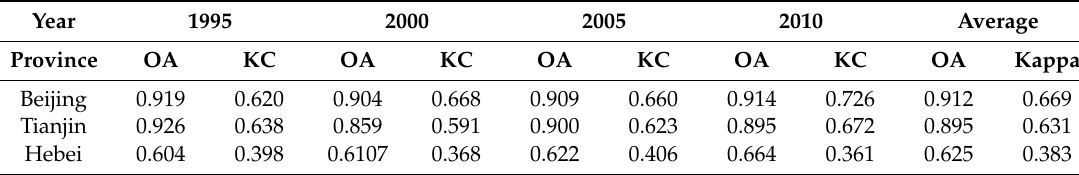
Table 3. Accuracies for different cities based on NTL.